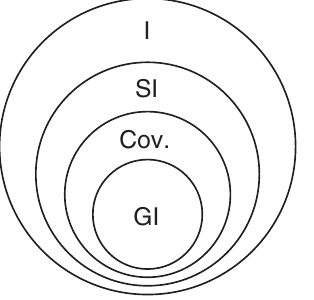
FIG. 4. Hierarchy of classes of incoherent operations: incoher- ent (I), strictly incoherent (SI), covariant (Cov.), and genuinely incoherent